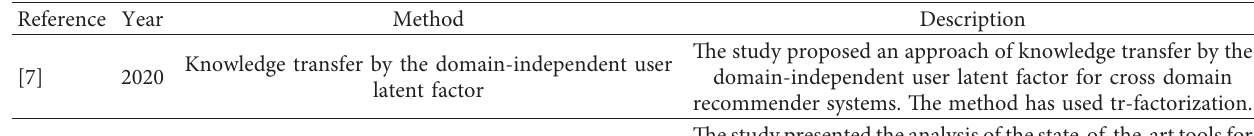
Table 1: Techniques and their